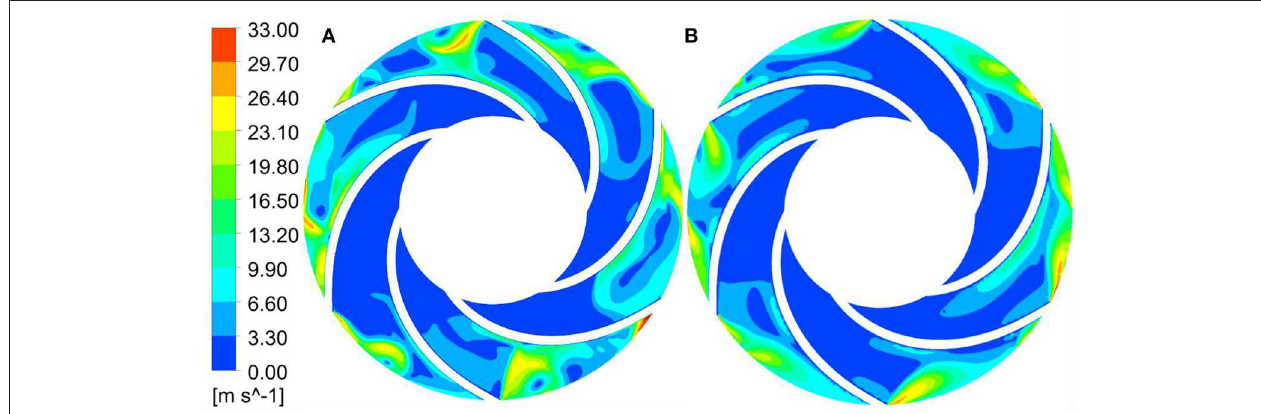
FIGURE 7 | Velocity distribution of the first stage impeller with n = 1,800 r/min. (A) Start-up transient of closed-valve, (B) steady state at the same speed.